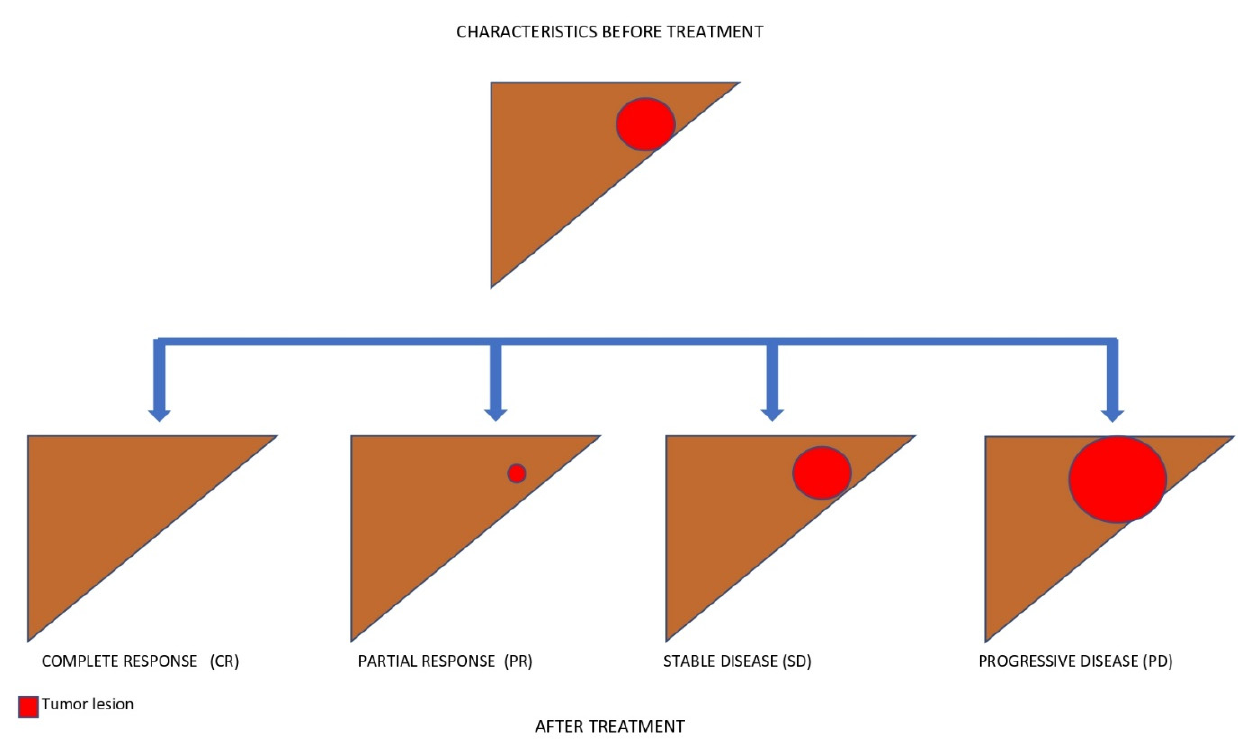
Figure 4. Radiological response according to RECIST 1.1.